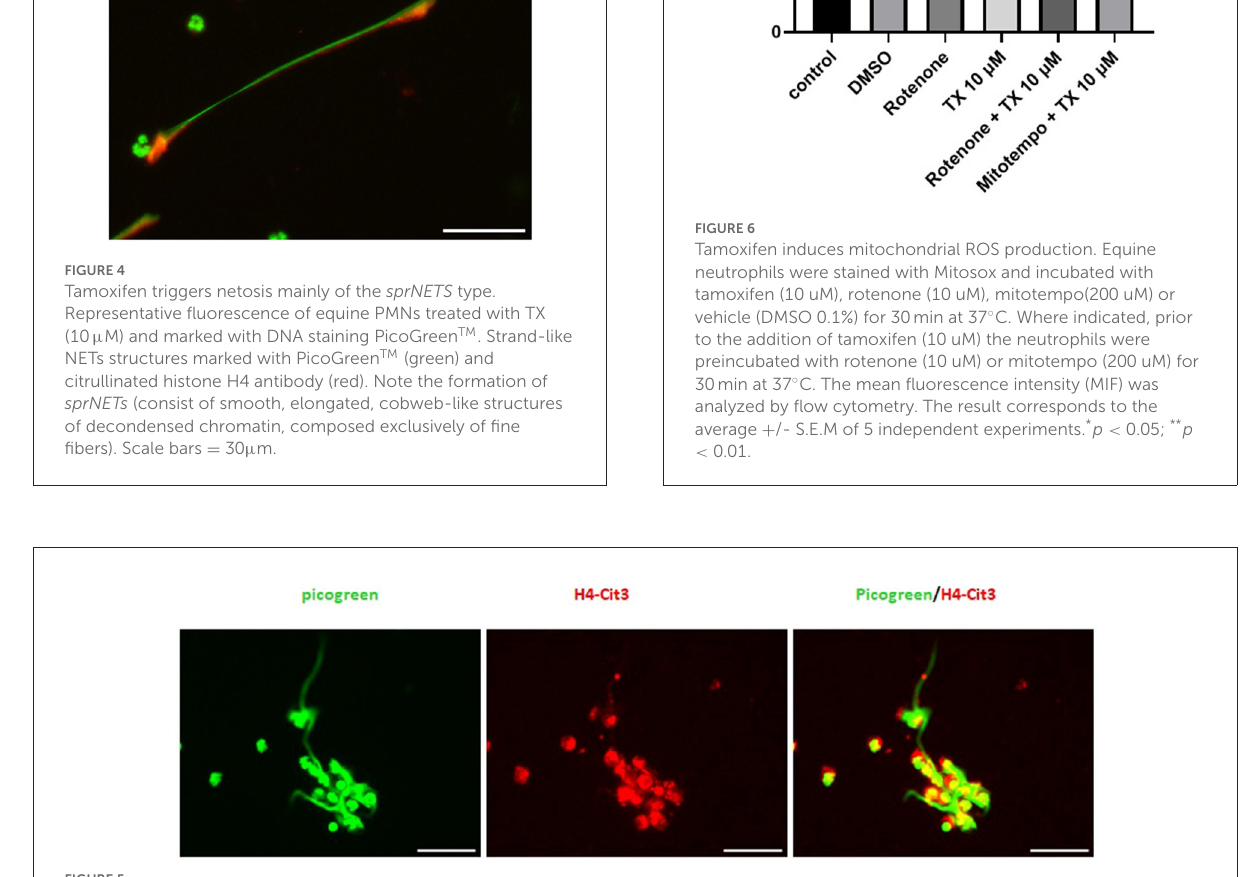
FIGURE5 Tamoxifen triggers aggNETs type netosis in a very low percentage. Representative fluorescence of equine PMNs treated with TX (10 µ M) and marked with DNA staining PicoGreen TM . Strand-like NETs structures marked with PicoGreen TM (green) and citrullinated histone H4 antibody (red). Note the formation of aggNETs defined as clusters of NET-like structures with a “ball of yarn”